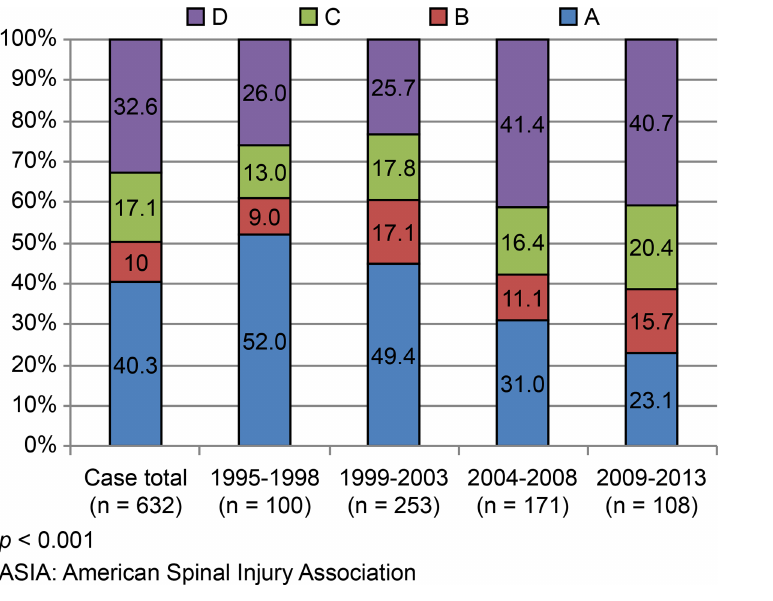
Fig 3. ASIA impairment scale (distributions at set